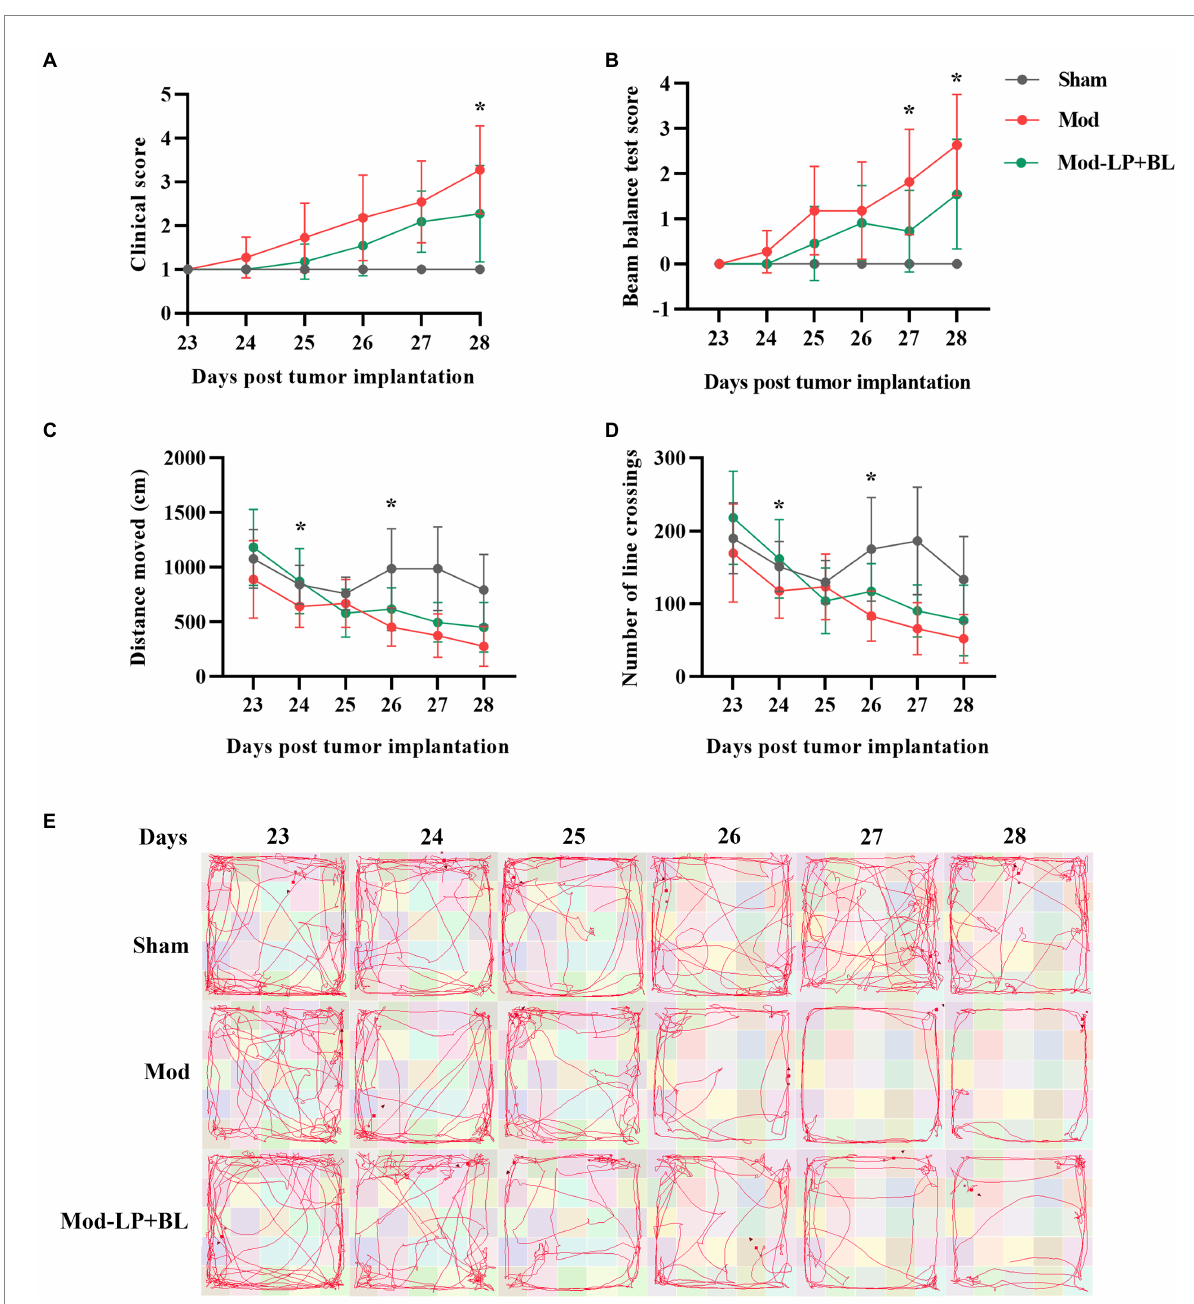
FIGURE 2 Effects of B. lactis and L. plantarum on neurobehavior in glioma mice. (A) Clinical score and (B) beam balance test score of mice at day 23 to 28 post tumor implantation. (C) Distance moved and (D) number of line crossings in the open field of mice at day 23 to 28 post tumor implantation. (E) Representative images of the movement track of mice in the open-field test. Mod, Model. LP, Lactobacillus plantarum ; BL, Bifidobacterium lactis . Two-way ANOVA . * p < 0.05. n =